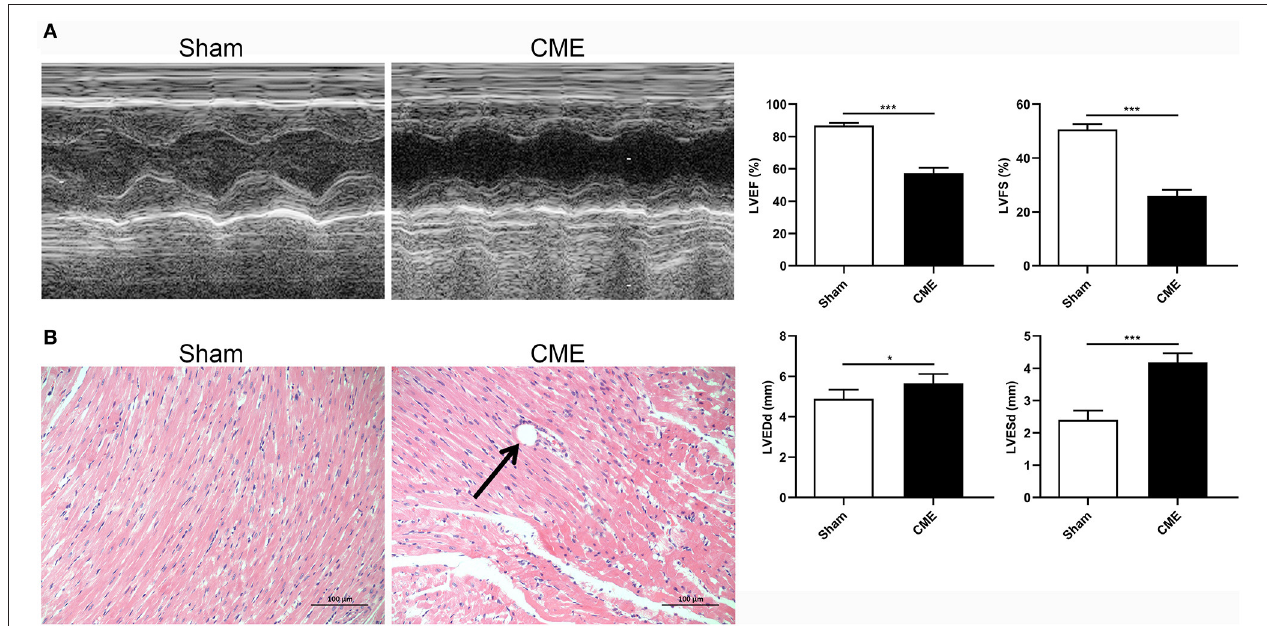
FIGURE 1 | CME induced myocardial injury in rats. (A) Echocardiographic analysis of cardiac function ( n = 6 per group), and corresponding comparison of left ventricle ejection fraction (LVEF), left ventricle fractional shortening (LVFS), left ventricular end-diastolic diameter (LVEDd), and left ventricular end-systolic diameter (LVESd). (B) Histopathological analysis by H&E staining ( × 200 magnification; bar = 100 µ m) ( n = 3 per group). The data are presented as the mean ± standard deviation (SD). * P < 0.05, *** P < 0.001. CME, coronary